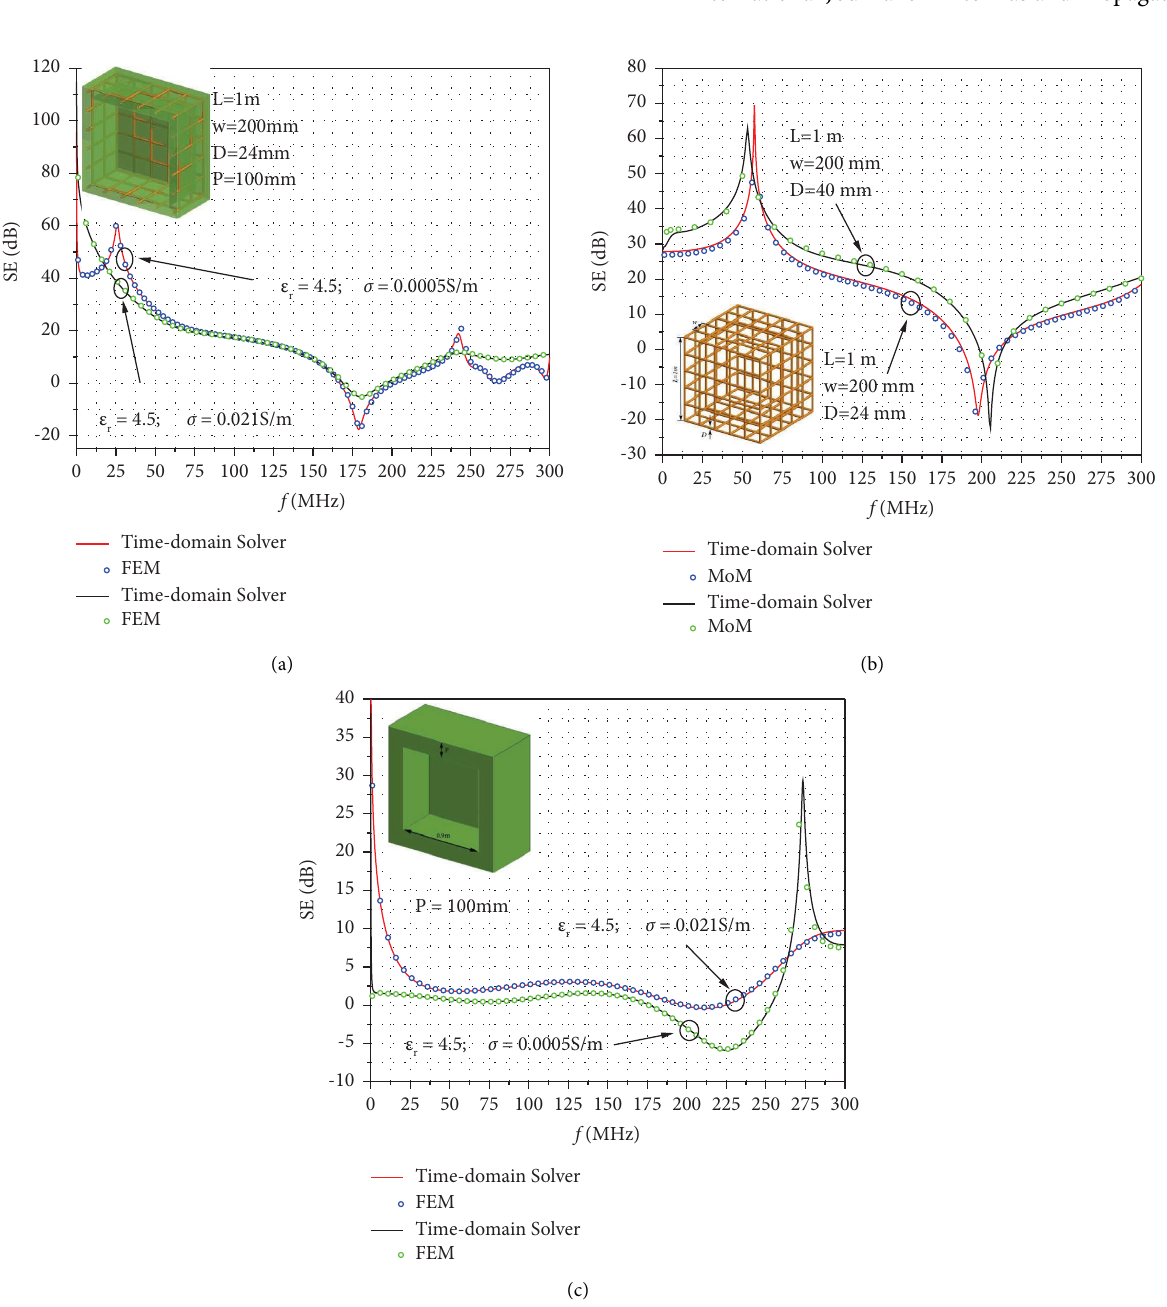
Figure 2: Shielding efectiveness calculation and verifcation of diferent cavity models: (a) reinforced concrete cavity, (b) steel cage, and (c) concrete